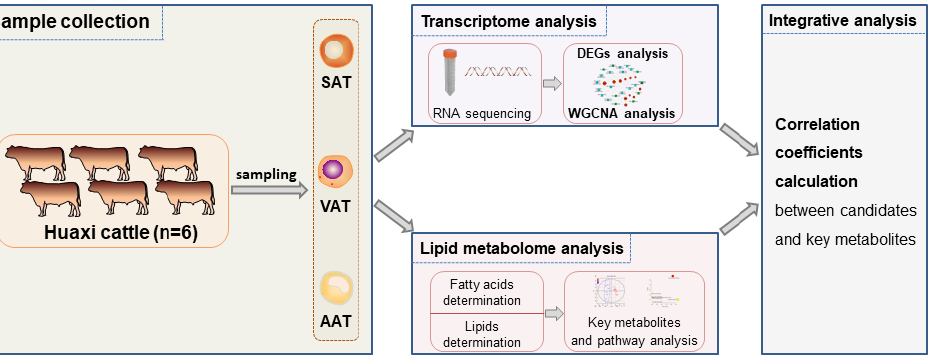
Figure 1. Technology roadmap. SAT: subcutaneous adipose tissue; VAT: visceral adipose tissue; AAT: abdominal adipose tissue; DEGs: differentially expressed genes; WGCNA: weighted gene co-expression